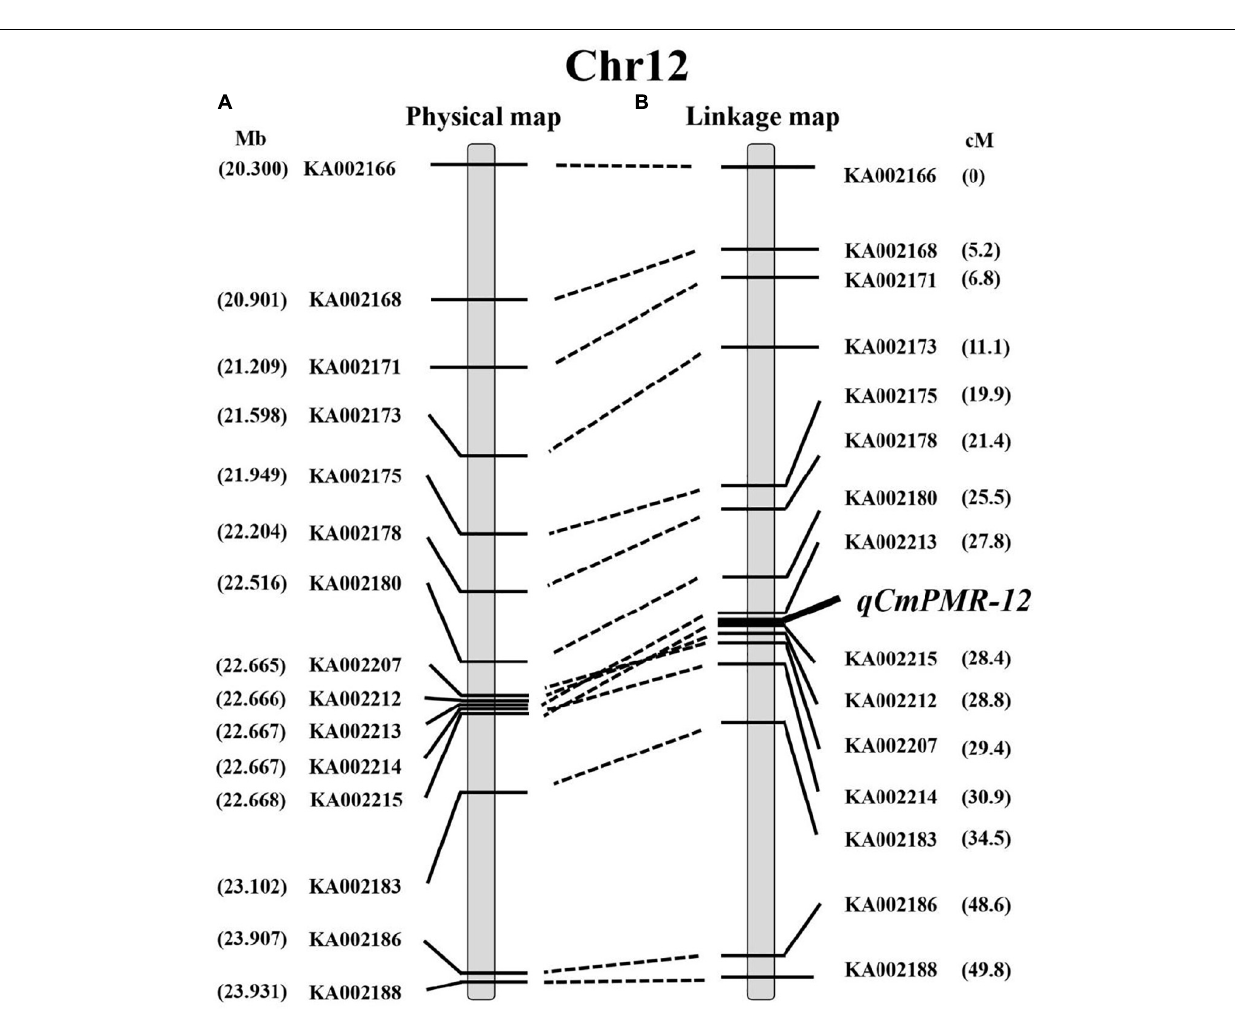
FIGURE 5 | The location of qCmPMR - 12 on melon chromosome 12. (A) The physical map around the region of qCmPMR - 12 ; marker names are indicated to the left of the map. (B) The genetic linkage map of melon chromosome 12; map distances are shown on the right. The QTL region was identified by QTL mapping using phenotypic analysis and marker data from F 2